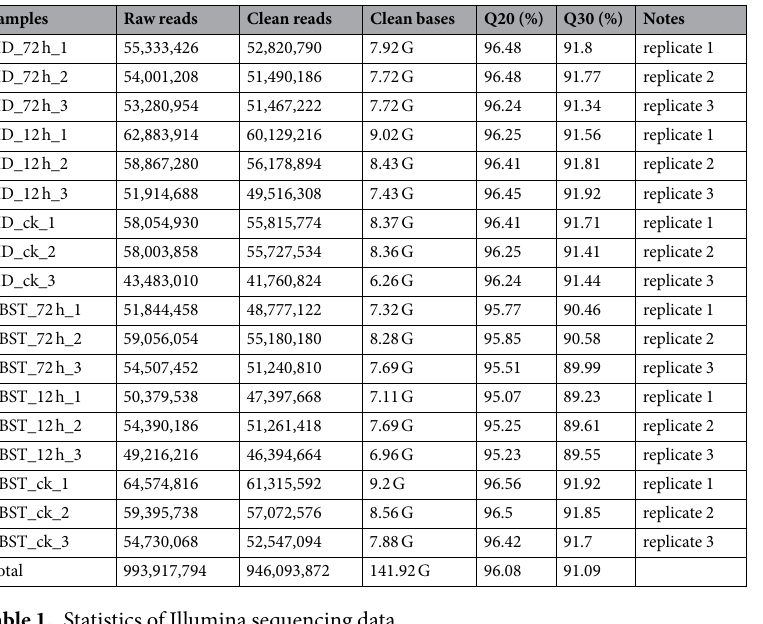
Annotation of unigenes in tobacco.